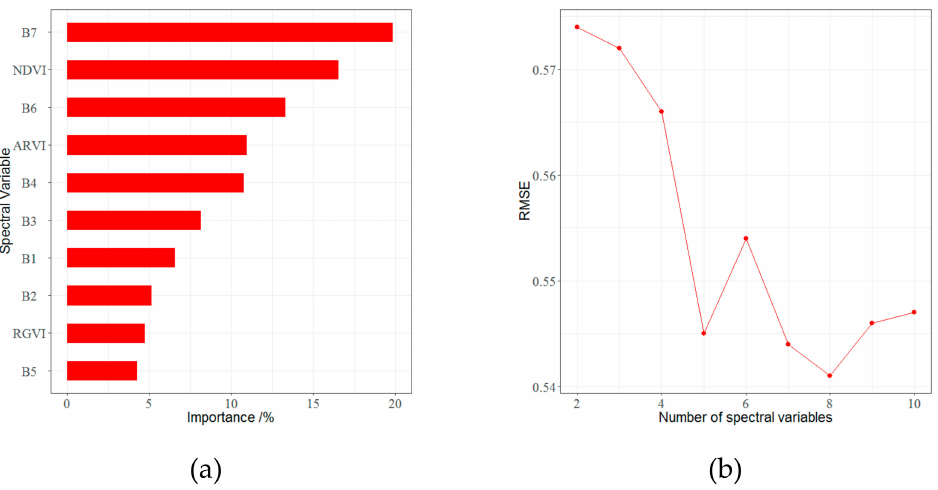
Figure 3. ( a ) The importance rank of spectral variables and ( b ) the RMSE values of the RF method with di ff erent numbers of spectral variables in